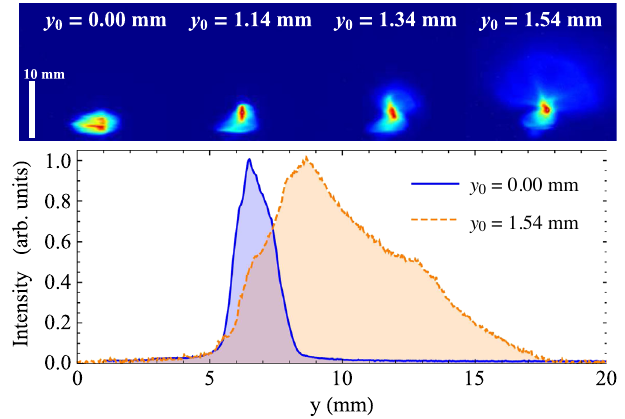
FIG. 2. Top: Beam images on the S5 screen at various offsets in the structure with the half-gap of a ¼ 2 . 0 mm. The bunch length is 800 fs and the rms horizontal beam size σ x 0 ¼ 360 μ m. Bottom: vertical projections at y 0 ¼ 0 and 1.54 mm.